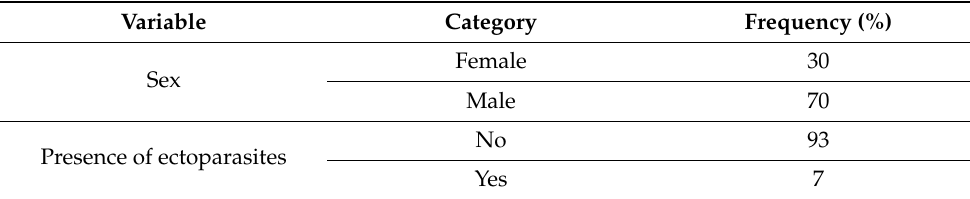
Table 8. Frequency of the variables for the true positive